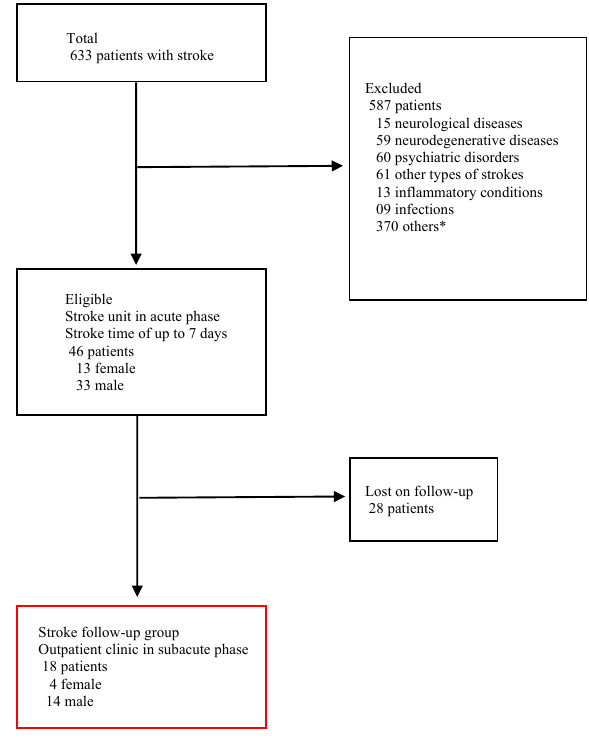
Figure 1. Flow diagram of patient